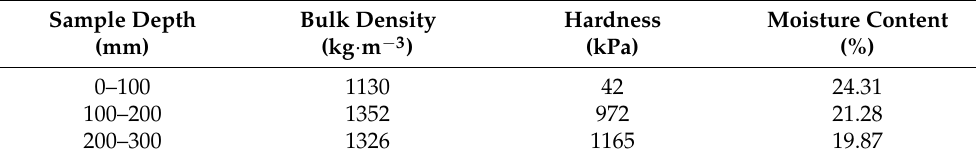
Table 1. Measured black soil physical